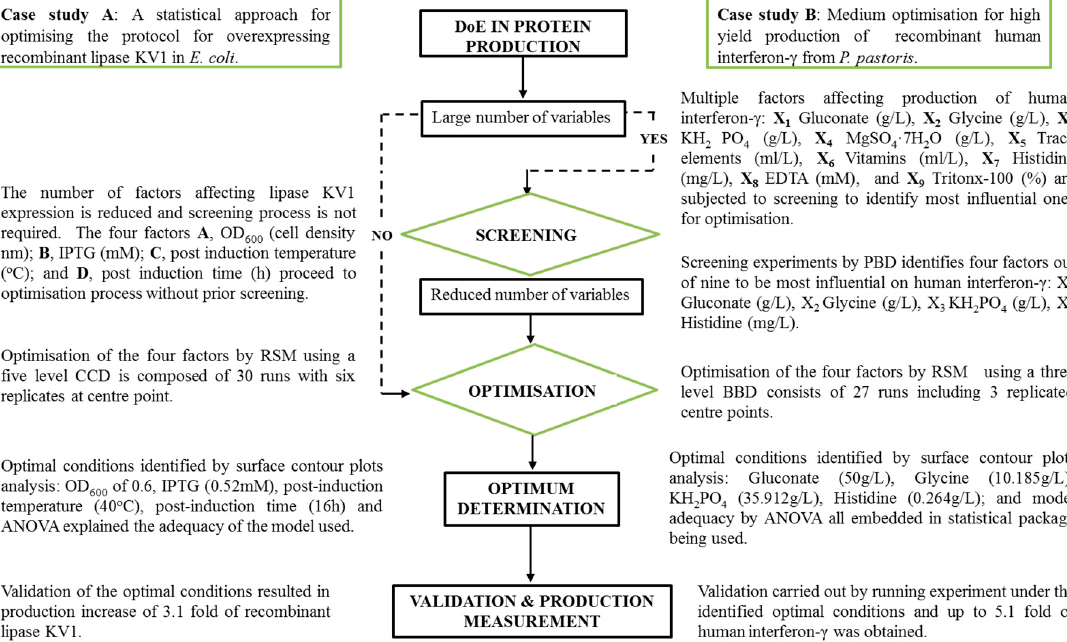
Figure 1. A typical DoE workflow in protein production. Case study A illustrates the optimization of recombinant lipase KV1 expression in E. coli [84] where a screening process was not required since the number of factors affecting this enzyme is not large (four factors). The four factors (A, B, C, D), therefore, underwent optimisation by Central Composite Design (CCD) under Response Surface Methodology (RSM) which resulted in a yield increase in protein expression of 3.1-fold. Case study B describes the optimisation process for high yield production of recombinant human interferon- γ [85]. In this case, the number of factors involved is large (nine factors) and they were subjected to a screening process before optimisation. Four factors (X 1 , X 2 , X 3 , X 7 ) out of nine were identified by Plackett-Burman Design (PBD) based screening to be the most influential and subsequently used for further optimisation. A Box-Benkhn Design (BBD) also under RSM was selected to optimize the screened factors and increased the production of human interferon- γ up to 5.1 fold. Further details of these two case studies can be found in the references provided and similar cases are found in Tables 4 and 7.